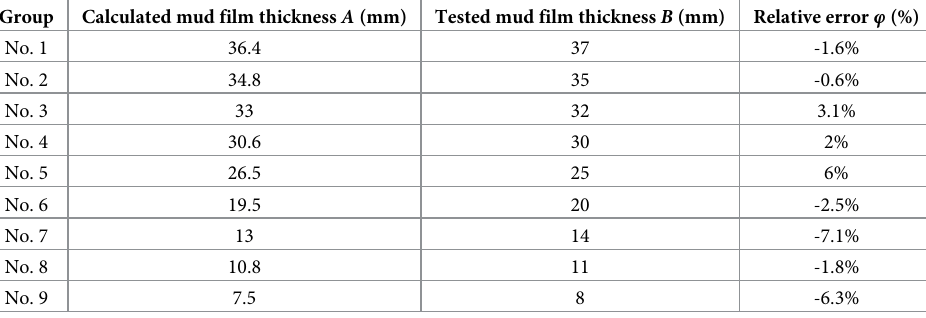
Table 3. Mud film thickness error of the theoretical calculation relative to the experimentally obtained